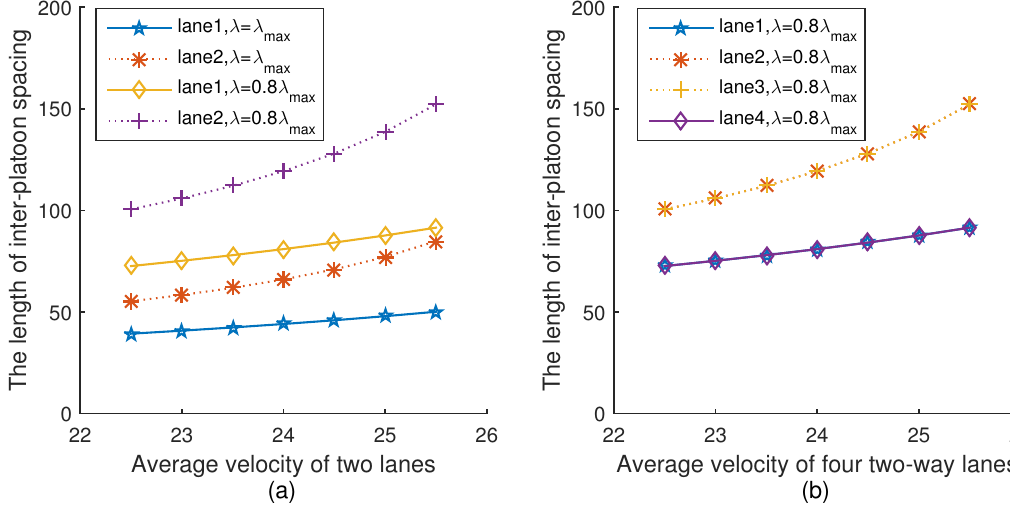
Figure 7. The inter-platoon spacing versus